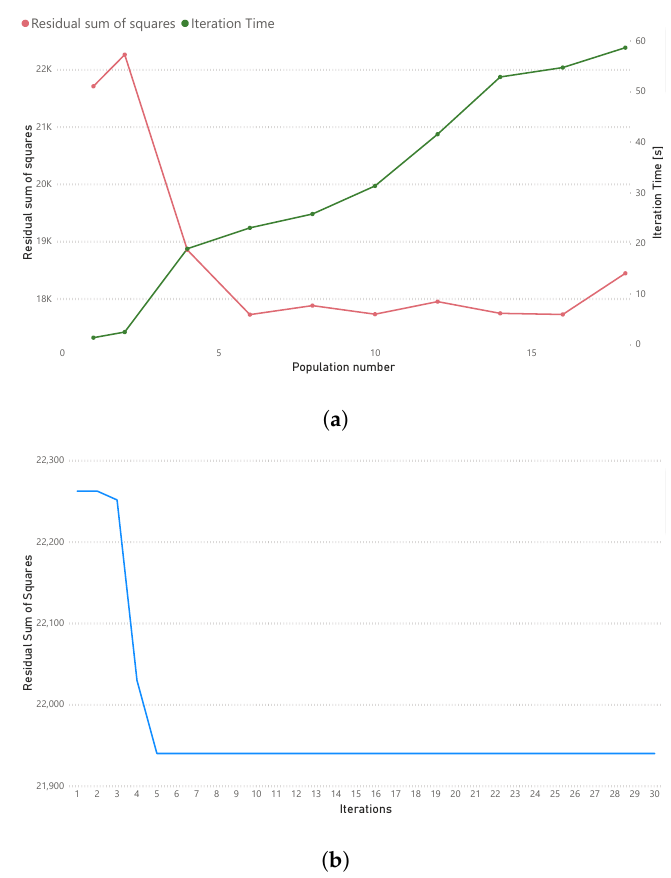
Figure 7. Analysis of iterations and populations of particles for minimization of RSS. ( a ) Population number vs. RSS and iteration time. ( b ) Number of iterations vs. RSS. Table 1. Convergence times of optimization algorithm based on number of particles and